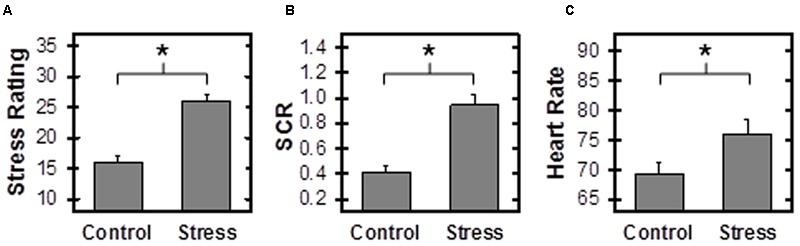
Stress Response. Self-reported stress (A), skin conductance response (SCR) (B), and heart rate (HR) (C) were higher during Stress than Control Montreal Imaging Stress Task (MIST) conditions. SCR, Skin Conductance Response, calculated as the beta estimate of the SCRs to Math events. ∗Reflects p < 0.05.